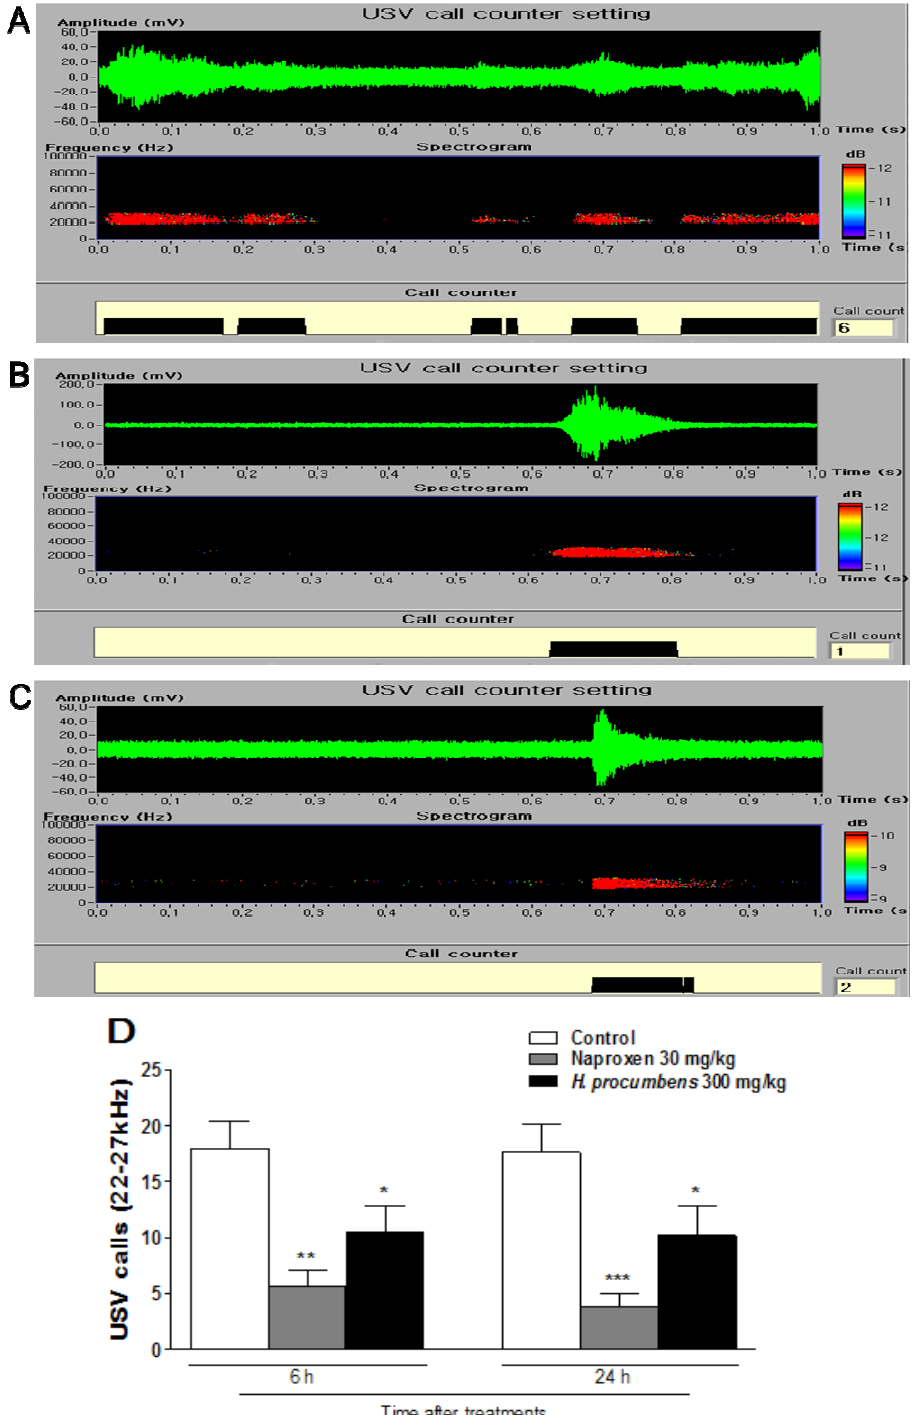
Figure 2. Effect of H. procumbens extracts on USVs induced by plantar incision in rats. The sonograms of USVs in ( A ) control, ( B ) naproxen- and ( C ) H. procumbens extract- treated rats. ( D ) A significant difference in 22–27 kHz USVs was observed between the H. procumbens extracts (300 mg/kg) treated group and the control group. Data are mean ± SEM (n = 6 per group). * p < 0.05, significant difference from the control